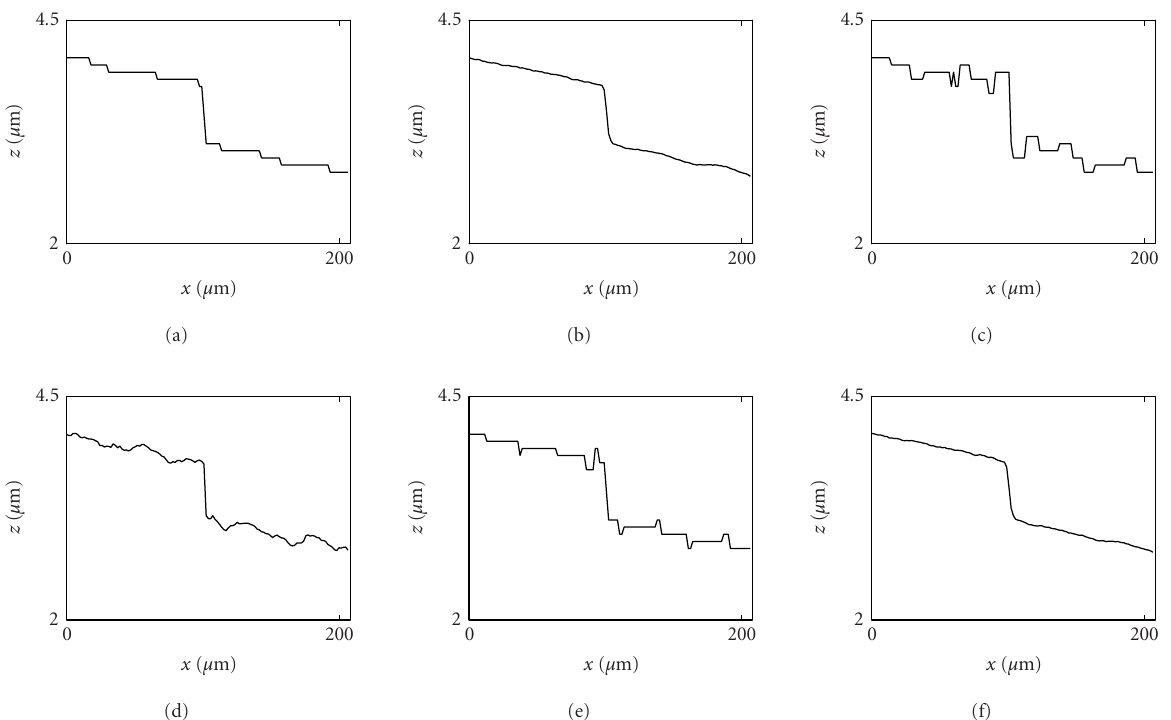
Figure 5: Surface detection. Without splines: (a) ( k , m ) = (0,1), err = 25 . 6nm; (c) ( k , m ) = (2,2), err = 69 . 4nm; and (e) ( k , m ) = (2,3), err = 60 . 6nm. With splines: (b) ( k , m ) = (0,1), err = 14 . 5nm; (d) ( k , m ) = (2,2), err = 43 . 9nm; and (f) ( k , m ) = (2,3), err = 13 . 4nm.